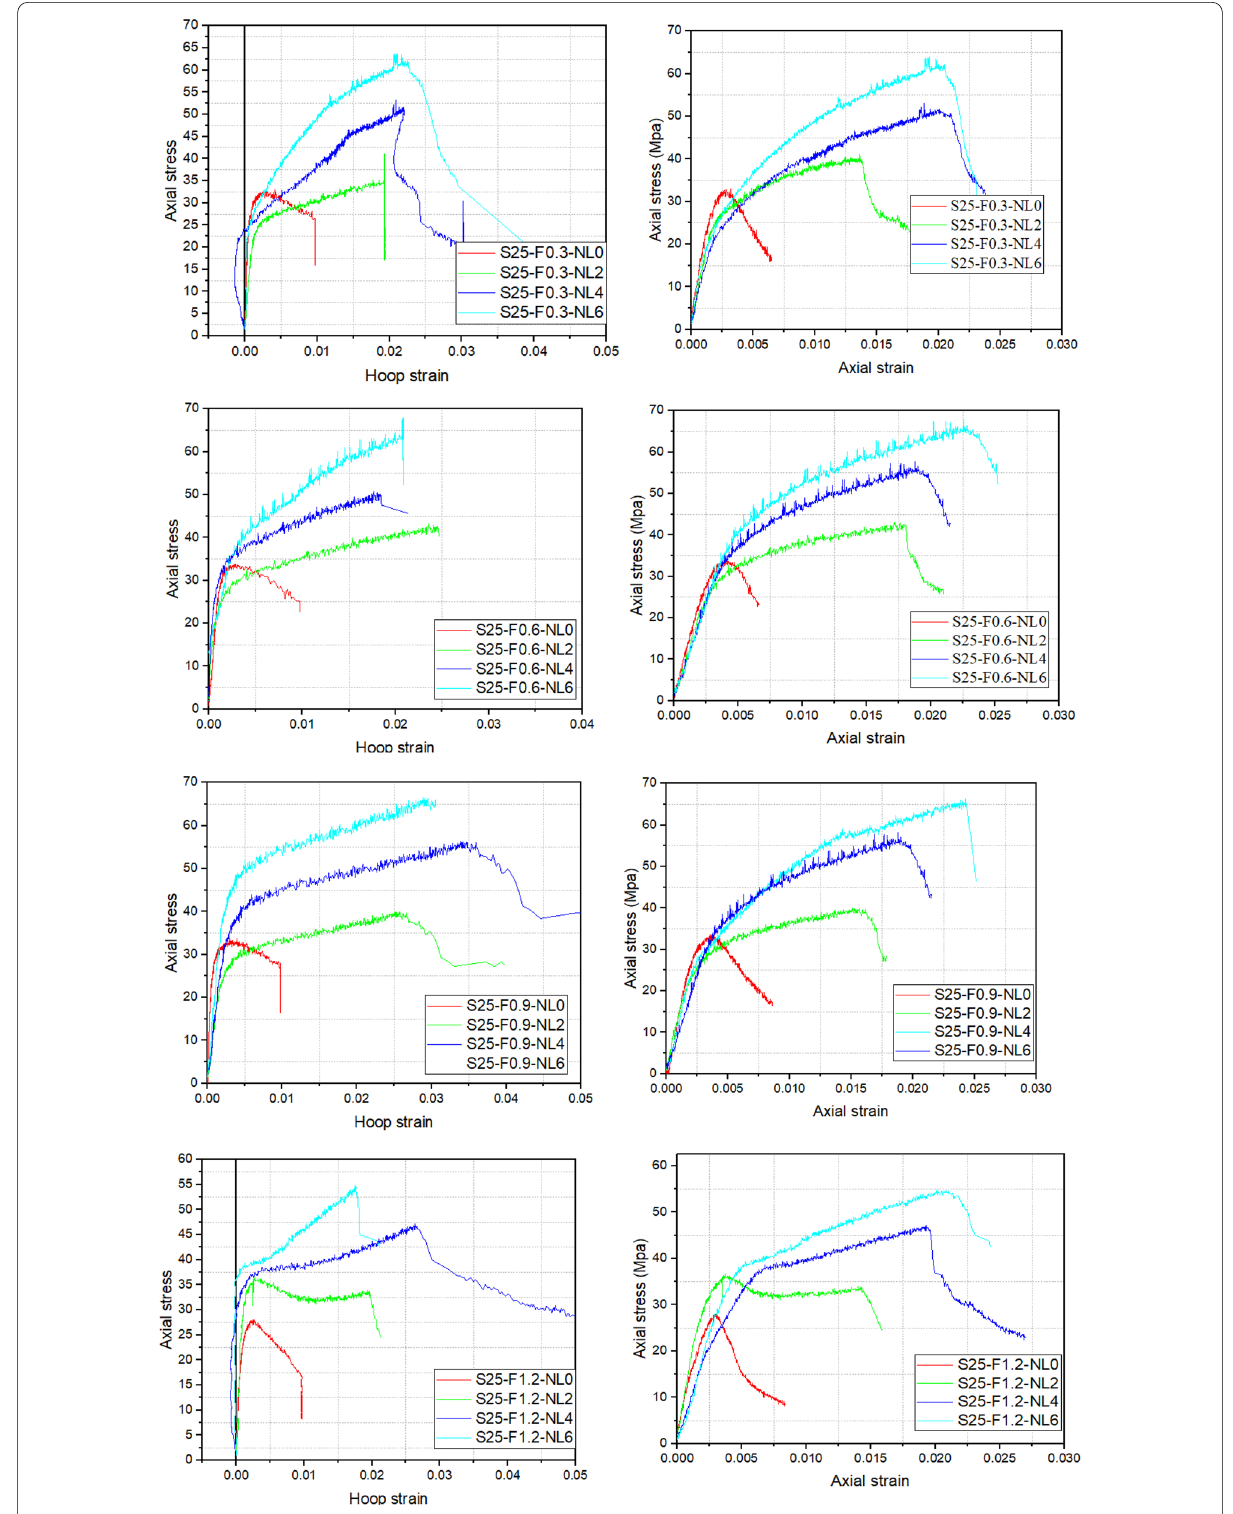
Fig. 9 Stress versus strain responses